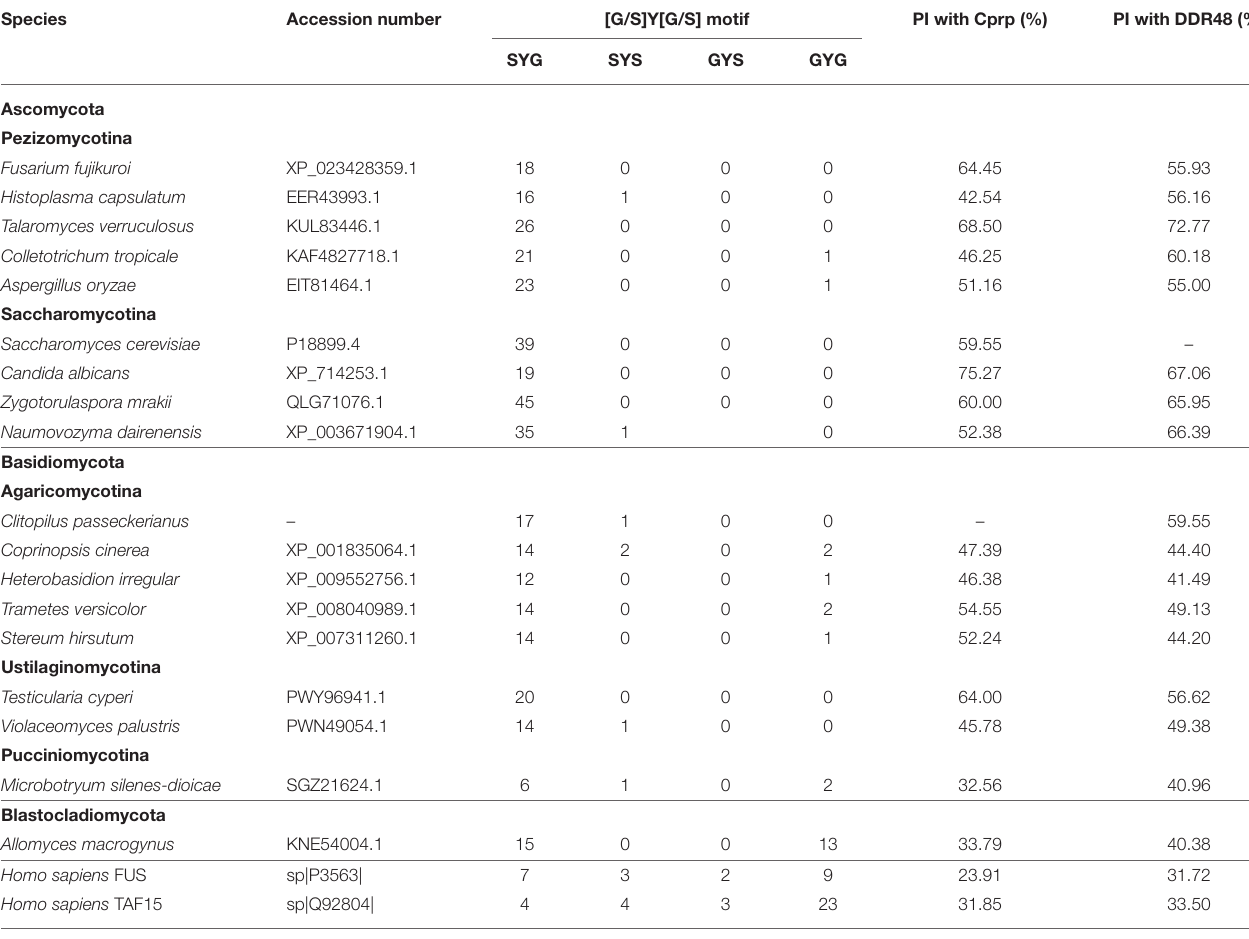
TABLE 1 | Representative DDR48-like proteins identified across the higher fungi.